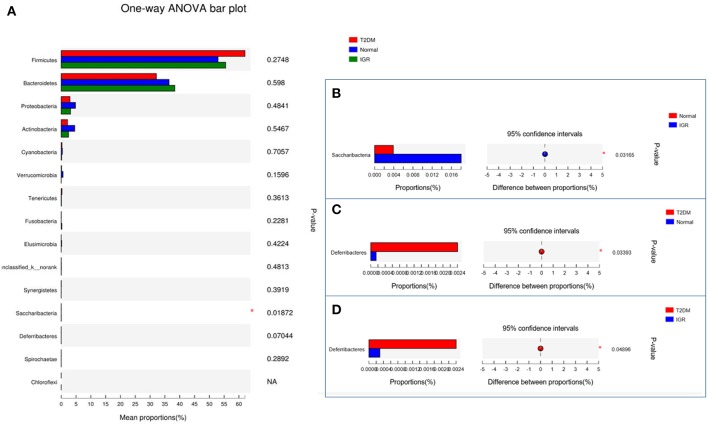
Bar plot of gut microbiota comparison at phylum level of three groups. (A) Gut microbiota comparison in three groups. (B) Saccharibacteria comparison in NC and IGR groups. (C) Deferribacteres comparison in NC and T2DM groups. (D) Deferribacteres comparison in T2DM and IGR groups; *Compare groups, P < 0.05.